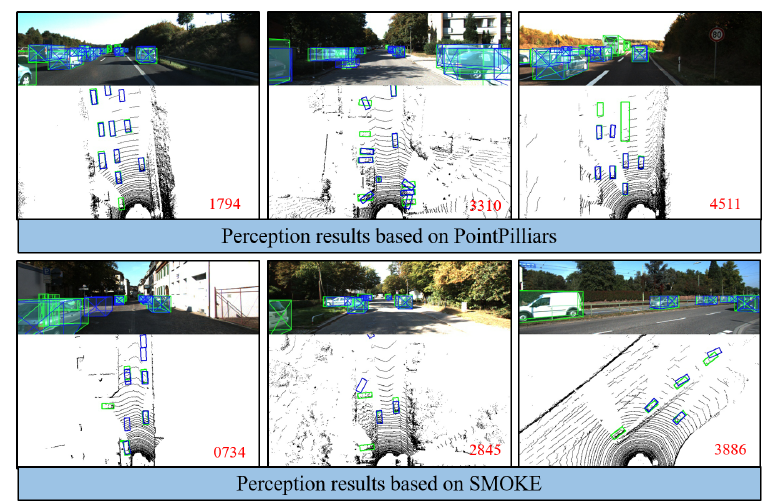
Figure 1. Comparison graph between ground truth and perception results under the KITTI dataset based on DNN algorithms. There is uncertainty in perception results, such as missed detection, false detection, position errors, and orientation errors. Green boxes represent the ground truth of data labels and blue boxes donate the perception results of DNN algorithms based on lidar and camera. The red numbers represent the order of the dataset